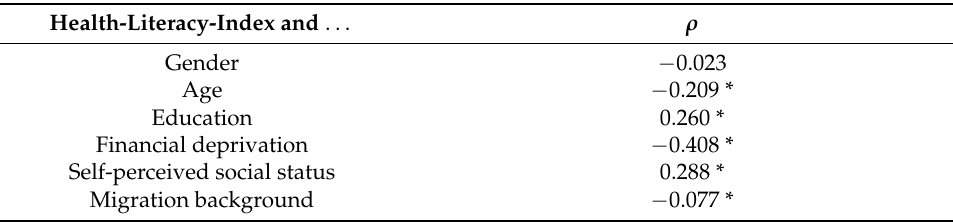
Table 3. Correlations between Health-Literacy-Index and sociodemographic characteristics. Health-Literacy-Index and . . .